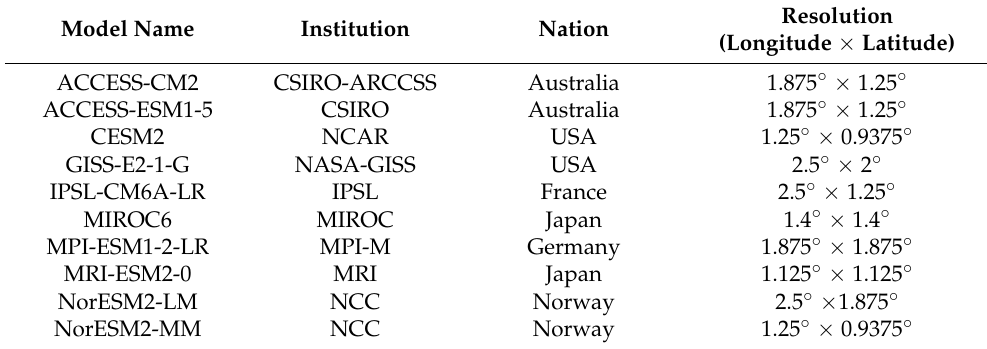
Table 1. CMIP6 models used in this